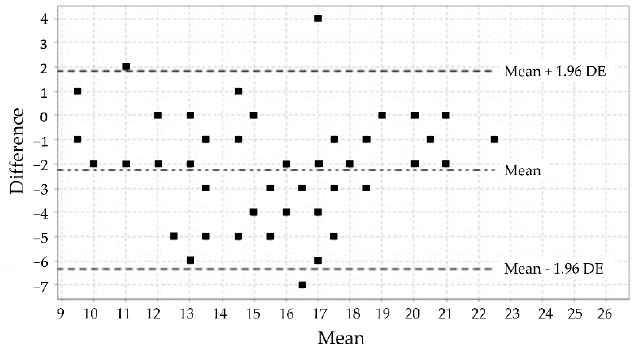
Figure 1. Bland–Altman plot of the internal visual subscale of the MIQ-3.